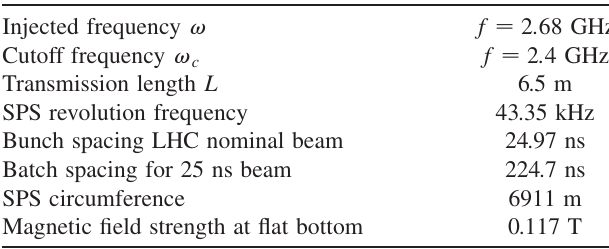
TABLE I. Parameters of the experimental setup and the CERN